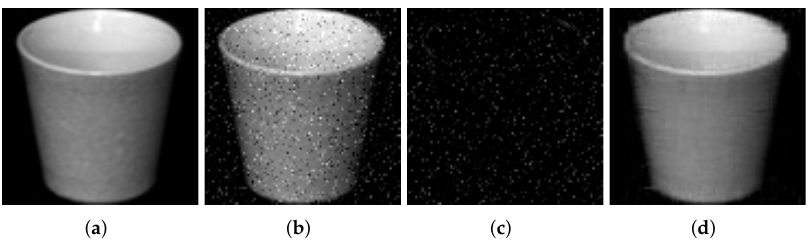
Figure 3. Illustration of noise removal of a single image from Coil20 dataset. ( a ) Input image ( b ) Image with 20% sparse noise ( c ) Sparse noise content ( d ) Noise removed